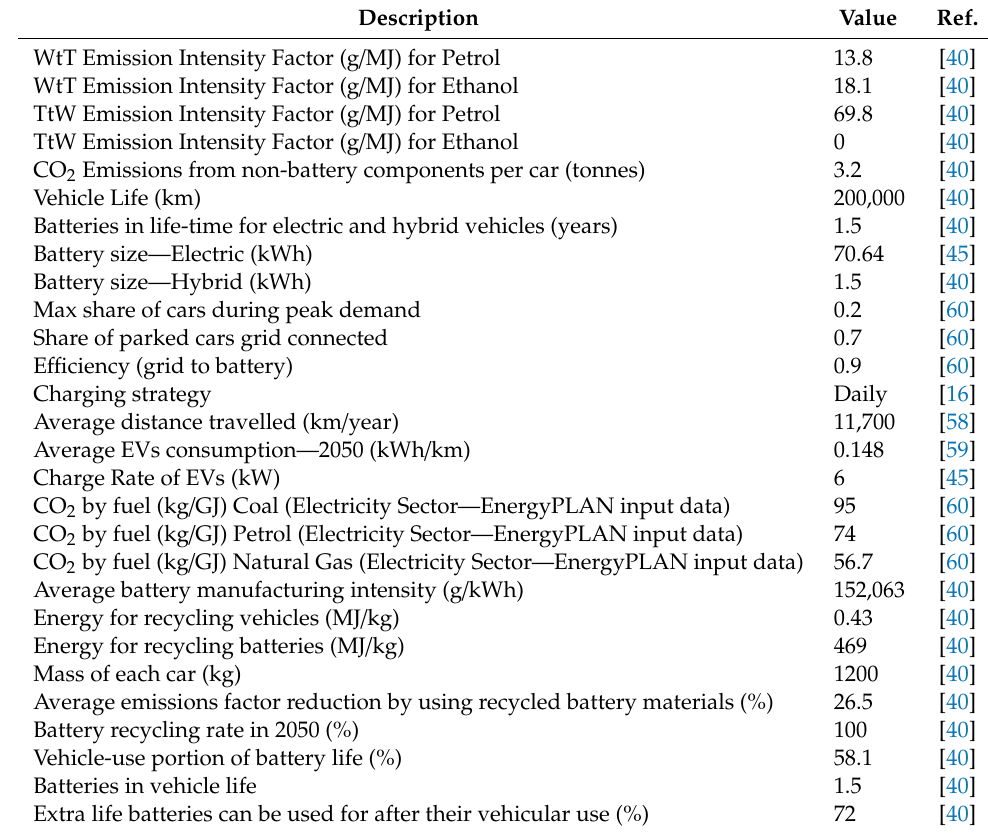
Table A2. Other input